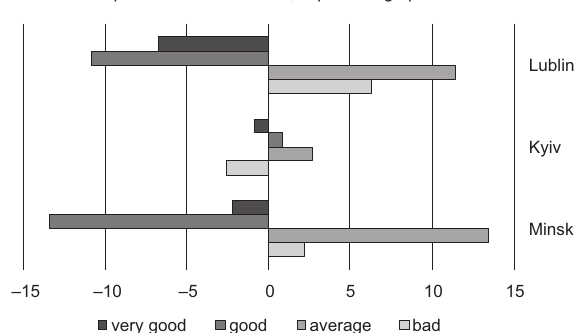
Fig. 2. Self-assessment of the respondents’ state of health in Lublin, Kyiv and Minsk before and during the pandemic, percentage points (n = 380). Source: own elaboration based on survey results